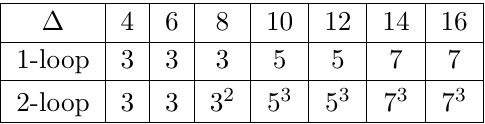
Table 9 . Largest prime number in the denominator of dilatation matrix